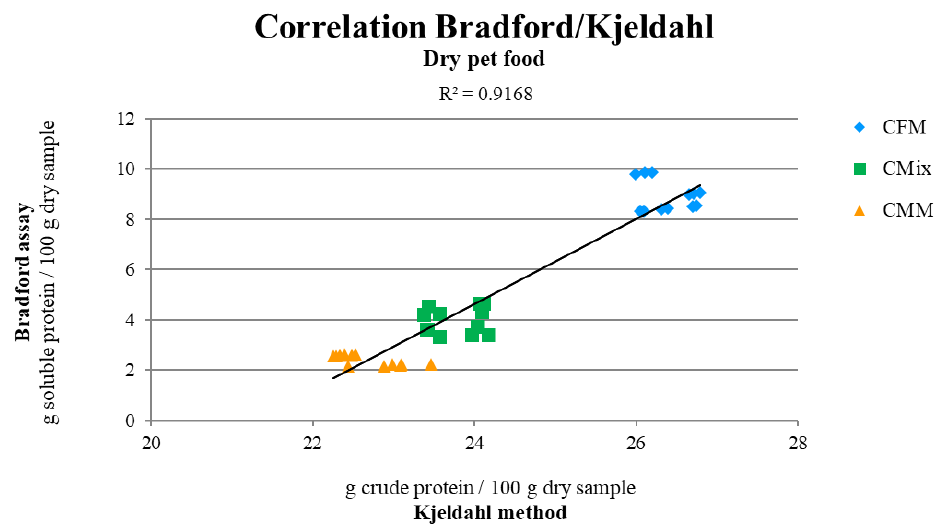
Figure 1. Correlation between the soluble and crude protein contents of CFM, CMix, and CMM formulations determined by the Bradford assay and the Kjeldahl method. Data are reported as mean, n =